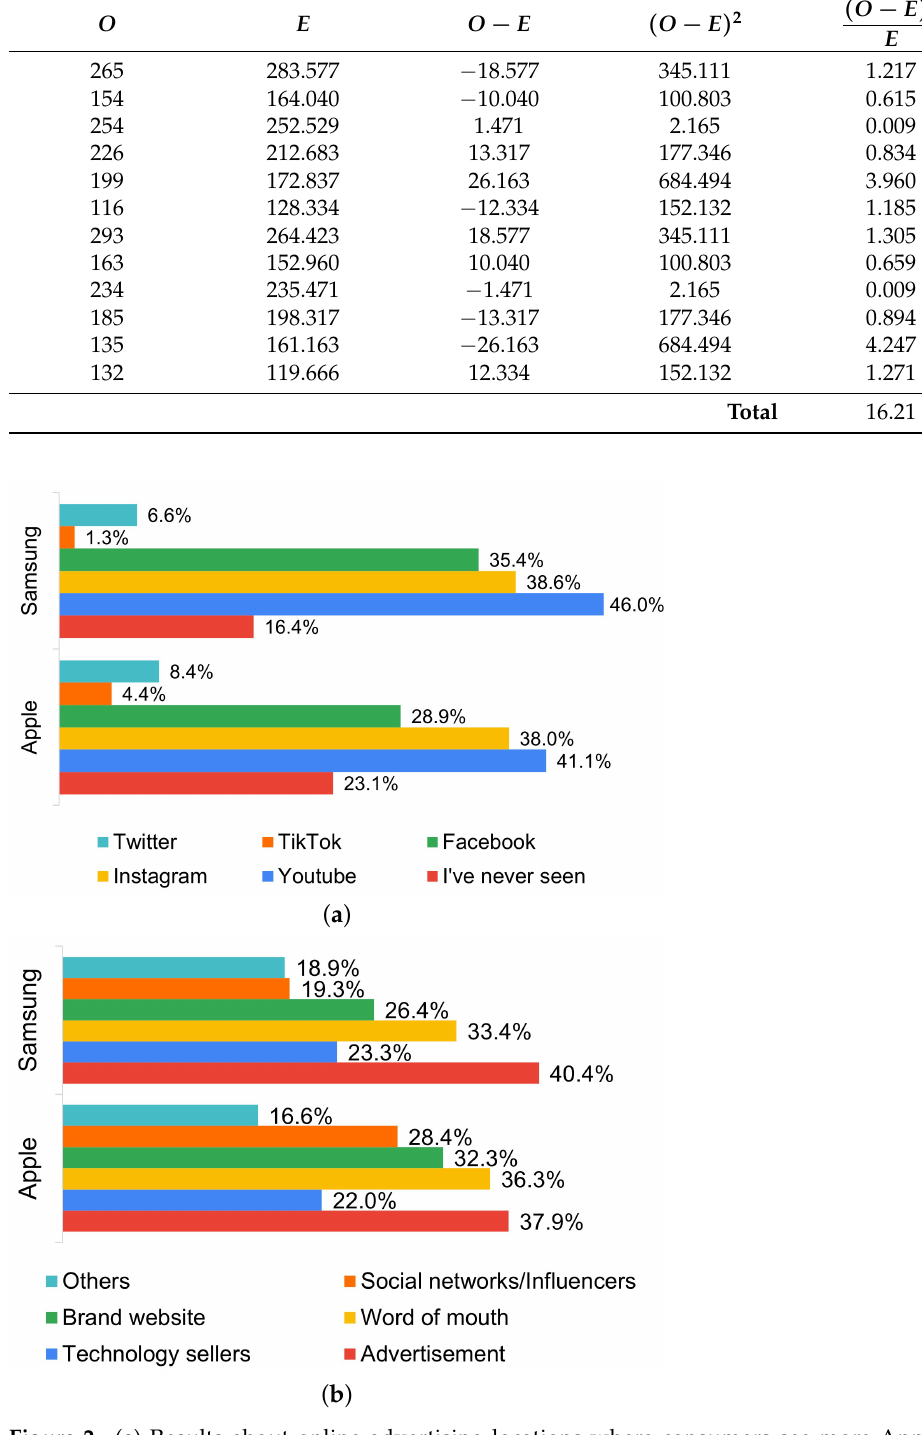
Figure 2. ( a ) Results about online advertising locations where consumers see more Apple and Samsung ads. ( b ) Results on the source of information for electronic devices, according to consumers, for Apple and